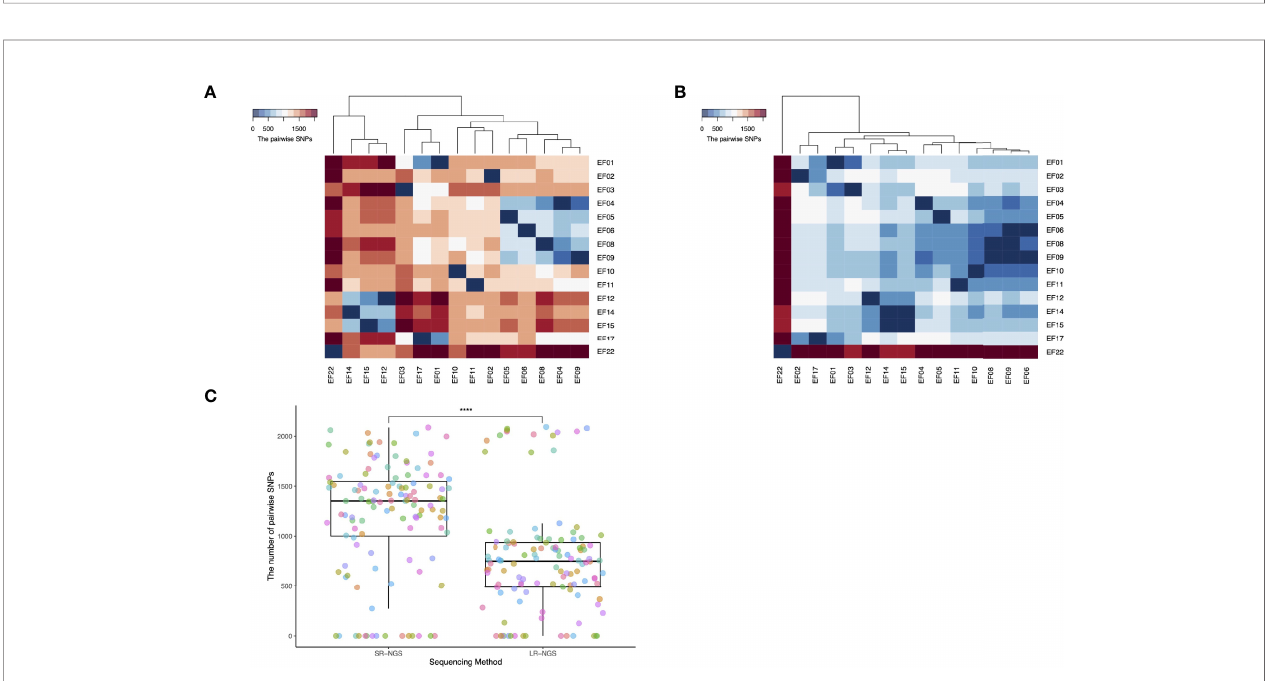
FIGURE 2 | Single-nucleotide polymorphisms (SNPs) detected by whole-genome sequencing of vancomycin-resistant Enterococcus faecium (VREfm) isolates. (A) and (B) show the pairwise SNPs generated by short-read next-generation sequencing (SR-NGS) and long-read next-generation sequencing (LR-NGS). Each row and column in both heatmaps indicates a VREfm isolate, and the columns were clustered using the hierarchical clustering method. (C) The Wilcoxon rank-sum test showed that the number of SNPs detected differed signi fi cantly between the two methods (****: p-value < vancomycin resistance pro fi ling. Although the vancomycin ( vanC(XY)TRS ) were detected in a single sample by both SR- resistance revealed by LR-NGS accorded with the PCR and LR-NGS. The type of vancomycin resistance was genotyping results, two vanA isolates were classi fi ed as con fi rmed using the MicroScan WalkAway system followed vancomycin susceptible by SR-NGS ( Figure 4 ). Regardless by PCR. The results were compared to those of the NGS